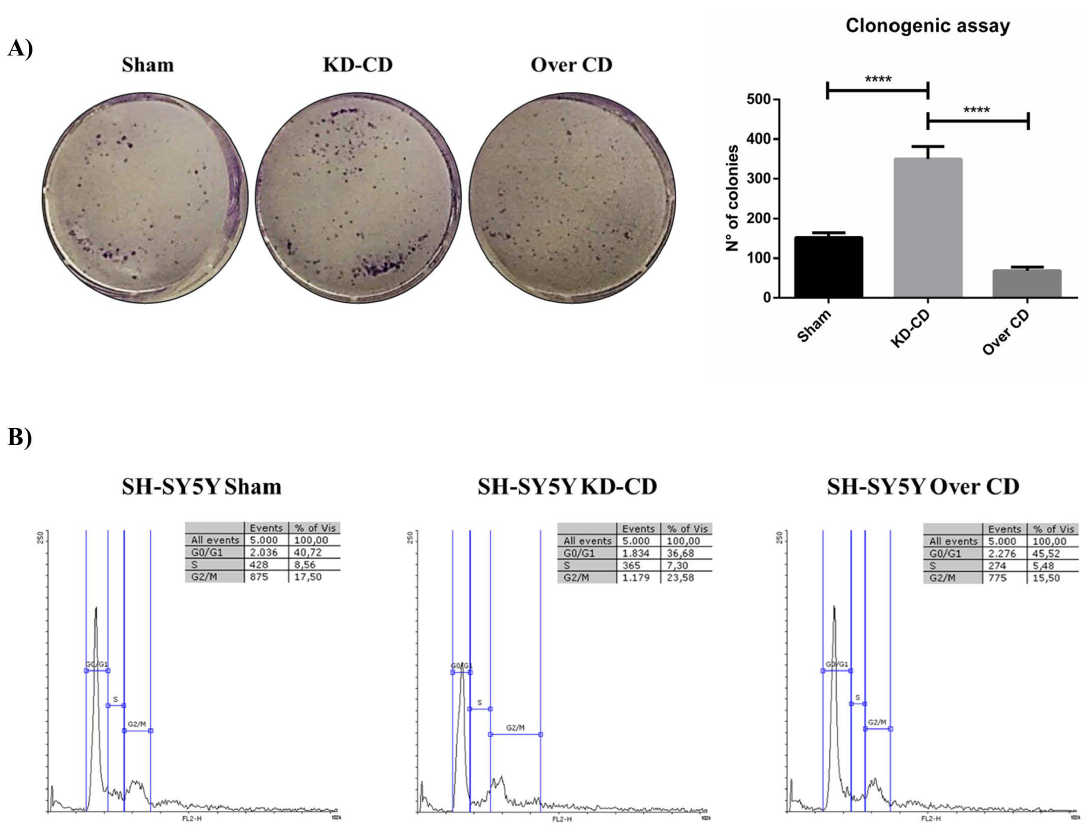
Figure 5. SH-SY5Y Sham, KD-CD and Over CD clones show different growth rates depending on CD expression levels. ( A ) Clonogenic assay and representative graph of the new colonies formed during 10 days of culture. Cells were seeded in 6-well plates and stained with 0.5% crystal violet solution. Images were acquired and colony counting was performed using CellCounter software. Cell growth and number of colonies were estimated through photometric measurements using CellCounter software and are shown in the graph. Data ± S.D. are representative of three independent replicates. Significance was considered as follows: **** p < 0.0001. ( B ) Cell cycle analysis performed at 72 h. The percentage of cell populations in different cell cycle phases is reported. Quantification was performed using Flowing software